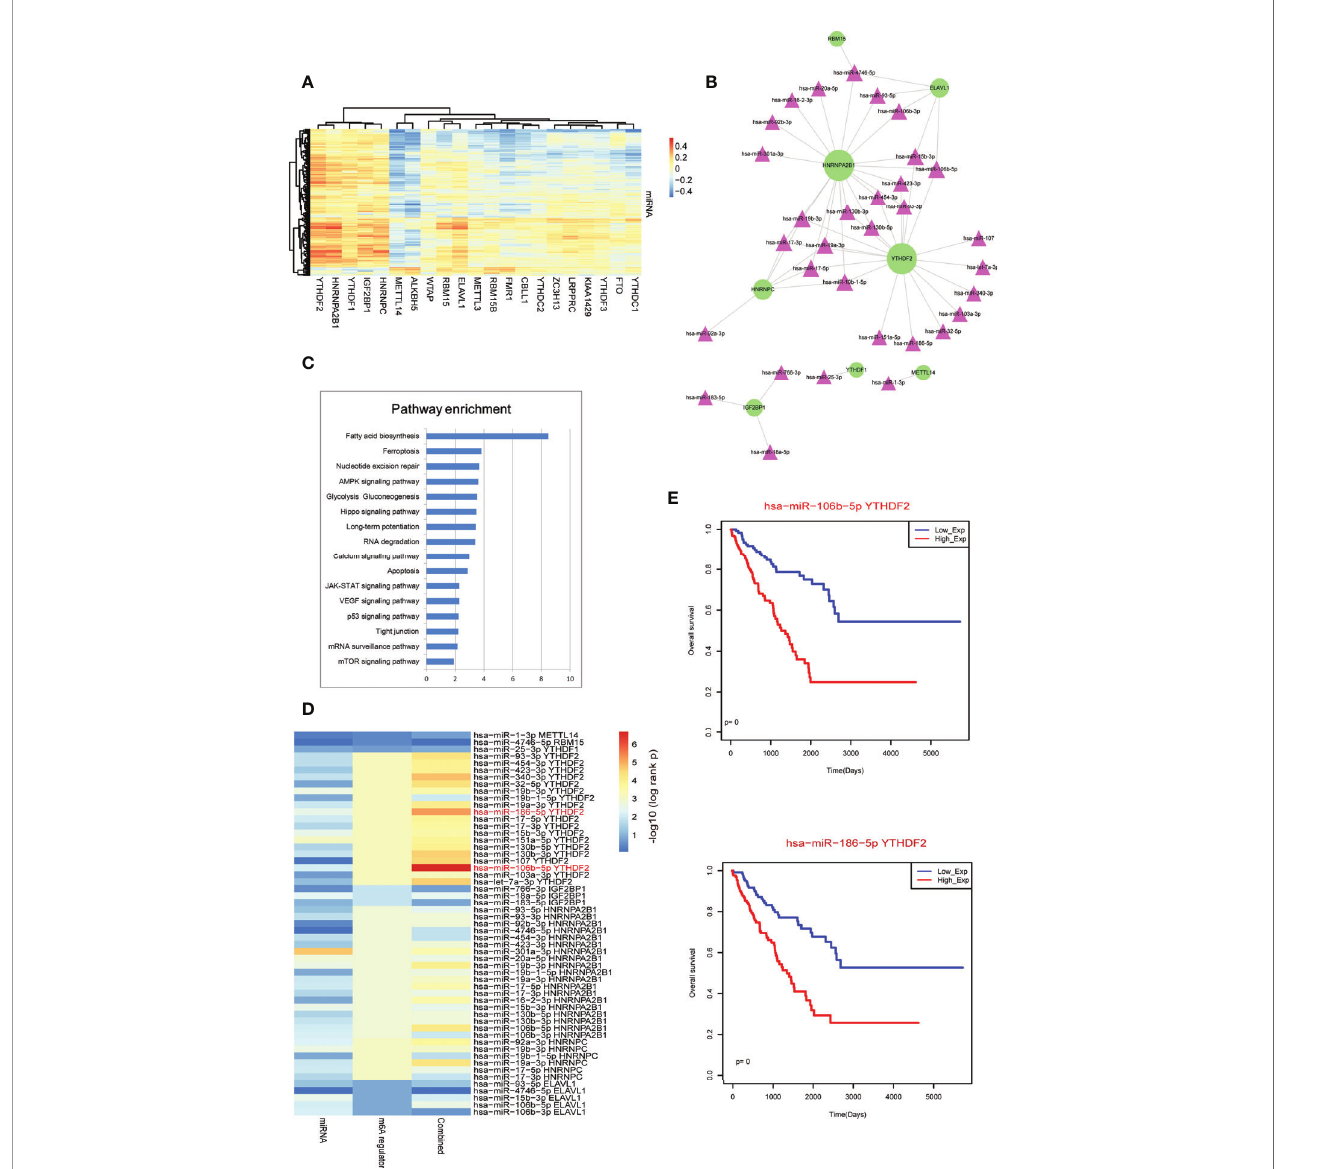
FIGURE 5 | Identi fi cation of m6A regulator-miRNA pairs in sarcoma. (A) The Pearson correlation heatmap of miRNAs and m6A regulators. (B) High-correlated m6A regulator-miRNA pairs. Green circular nodes represent m6A regulators and pink triangle nodes represent miRNAs. (C) Pathway enrichment analysis of miRNAs in network 5B by miEAA. Pathways were ranked based on – log10 (p-value). (D) Survival p-values of individual genes (including single miRNA and single m6A regulator) and combined signature (risk score model) in sarcoma. (E) The Kaplan-Meier survival curves of strong m6A regulator-miRNA